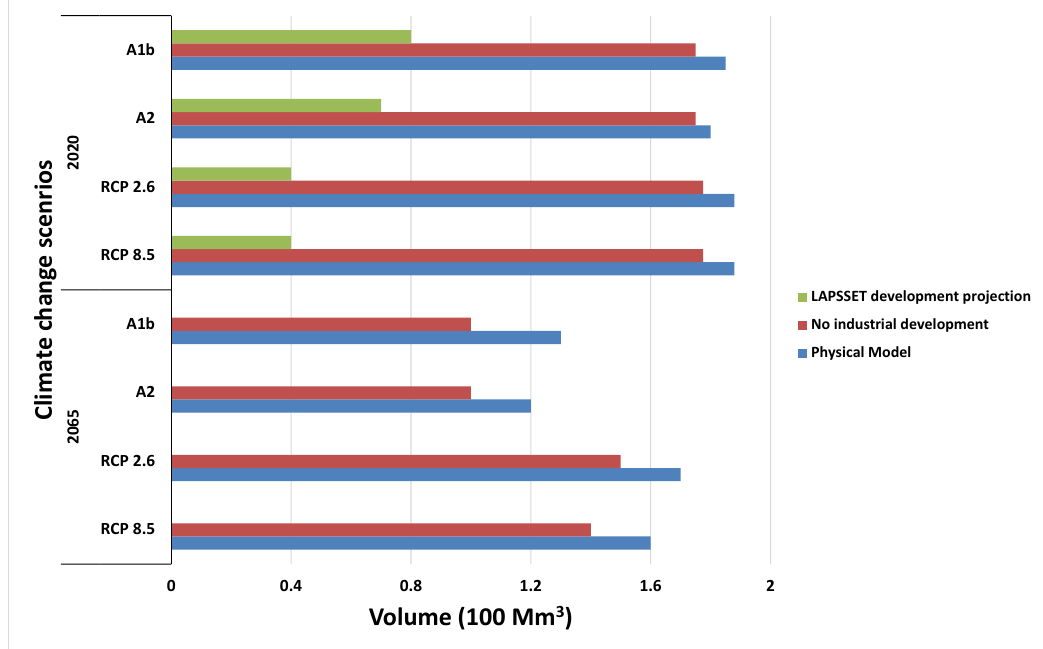
Figure 15. Graphical summary of the results in terms of water volumes vs. climate change scenarios for the near future (2020) and the long term (2065). The results highlight the complete depletion of the aquifer for the demographic model with the port completed (“LAPSSET